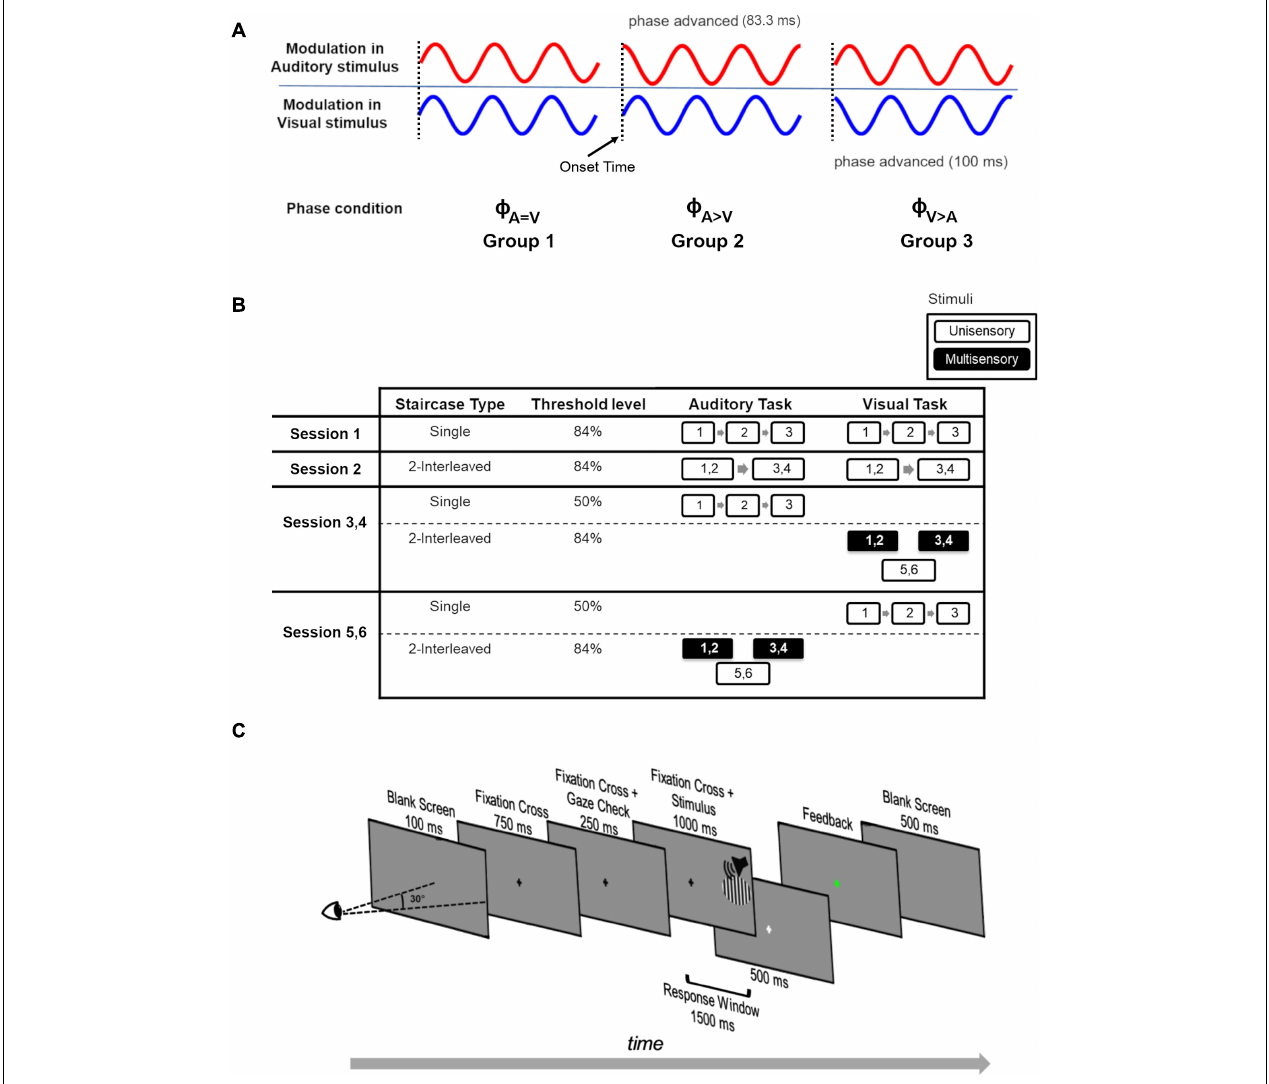
FIGURE 1 | Experimental design. (A) The phase of sinusoidally modulated stimuli across the three phase conditions for the three participant groups. For phase condition φ A = V (Group 1), the modulated stimuli have no phase-shift. For phase condition φ A > V (Group 2), the phase of the modulated auditory stimulus was phase-advanced by 83.3 ms. For phase condition φ V > A (Group 3), the modulated visual stimulus was phase-advanced by 100 ms. The onset time of all stimuli is the same (vertical dotted lines). (B) Experimental design of the study. Over six sessions (each session conducted on a separate day), participants performed a modulation detection task in a staircase design. Each executed staircase is represented by a numbered box. The number indicates the staircase number, and box size corresponds to the staircase duration. Each staircase measurement resulted in a modulation detection threshold. Depending on the staircase settings, either a 50 or 84% modulation detection threshold was measured (‘Threshold level’). White outlined and black filled boxes represent unisensory and multisensory conditions, respectively. In session 1, three repetitions (indicated by numbers 1–2–3) of single 84% detection threshold staircases were performed on unisensory auditory and visual stimuli. In session 2, participants executed 2-interleaved 84% detection threshold staircases, whose longer duration is indicated by larger boxes, twice each for unisensory auditory and visual stimuli. We then used two types of sessions to collect the multisensory data and associated unisensory control data. In the first type (repeated twice, designated Session 3, 4), three unisensory 50% correct staircases for the auditory task were administered followed by three 2-interleaved 84% correct visual staircases. Auditory stimuli were presented in two of these 2-interleaved 84% correct visual staircases (i.e., they were multisensory), and these staircases were used to measure the influence of auditory stimuli on performance in the visual task. In the second session type (repeated twice, designated Session 5, 6), three unisensory 50% correct staircases for the visual task were administered followed by three 2-interleaved 84% correct auditory staircases. Visual stimuli were presented in two of these 2-interleaved 84% correct auditory staircases (i.e., they were multisensory), and these staircases were used to measure the influence of visual stimuli on performance in the auditory task. Note that the order of the days for sessions 3–6 was randomized over participants. In addition, for sessions 3–6, the order of the 2-interleaved staircases (two multisensory and one unisensory) was varied over participants, but kept the same for an individual participant. (C) Experimental design of a single trial. Participants fixated on the fixation cross at the center of the screen. The stimulus was only presented if the participant maintained fixation (fixation error < 2.5 ◦ ) during the 250 ms gaze check prior to the stimulus presentation. The stimulus was auditory (white noise burst), visual (vertical grating, 6.2 ◦ in diameter) or audiovisual, and was presented at 28.5 ◦ azimuth in the participants’ right hemifield. The task of the participants was to indicate whether the attended stimulus was modulated or static. Feedback was given by a change in the color of the fixation cross (green = correct, red =